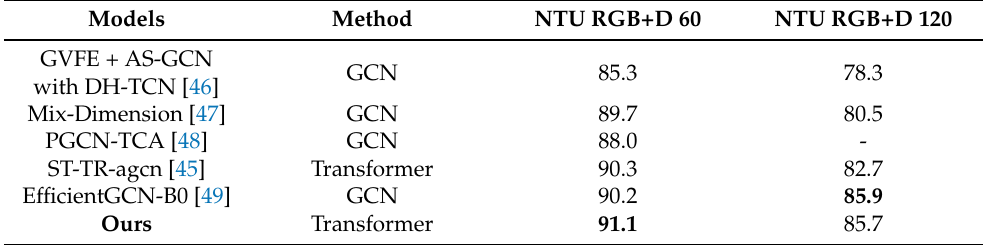
Table 2. The performance of the skeleton stream only compared to the state-of-the-art